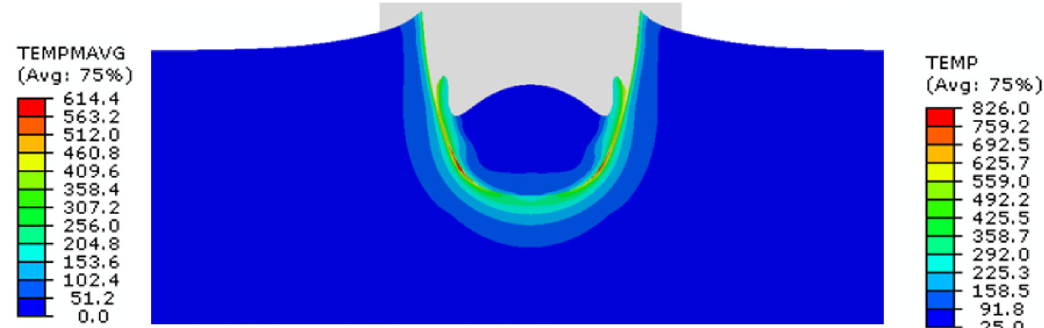
Fig. 11. Evolution of temperature (TEMP) and mass average temperature (TEMPMAVG) at 500m/s Cu/Al impact by using the CEL numerical